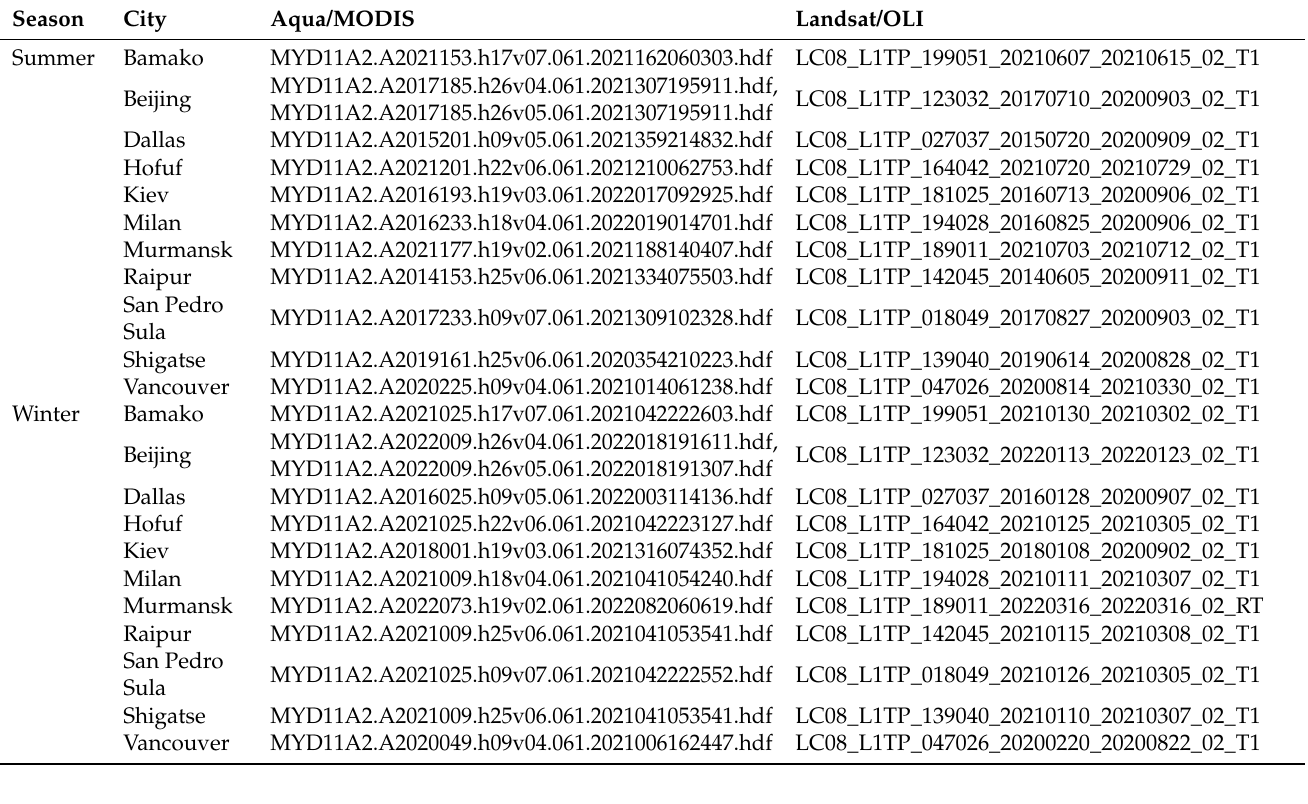
Table 2. Details of Aqua/MODIS LSTs and Landsat/OLI data used in this study.